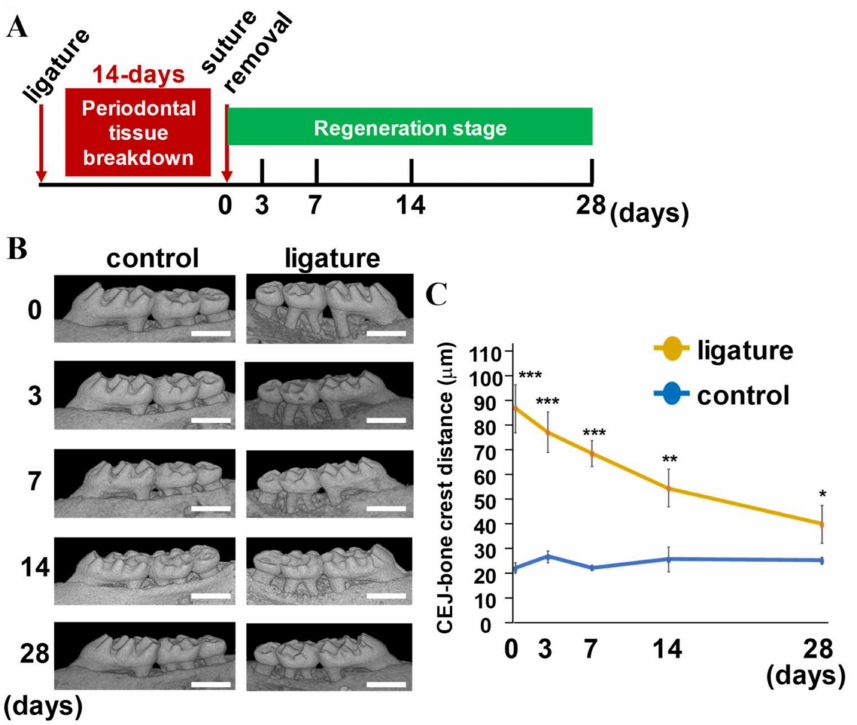
Figure 1. Quantitative analyses of the murine periodontal tissue regeneration model. ( A , B ) Schematic view of experimental design of the murine periodontal regeneration model and representative µ CT images of maxilla used for µ CT analyses. ( C ) The vertical distances from the CEJ to the alveolar bone crest at the mesial and distal roots on days 0, 3, 7, 14, and 28 were measured and summed ( n = 5). * p < 0.05; ** p < 0.01; *** p < 0.001 significantly different from non-ligature side. Scale bars correspond to 1000 µ